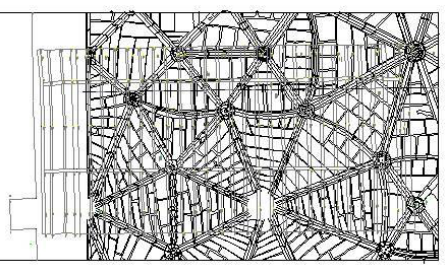
Figure 7. Plan with superposition of the intradors and extradors of the vault of the nave (Genin, 2002a).